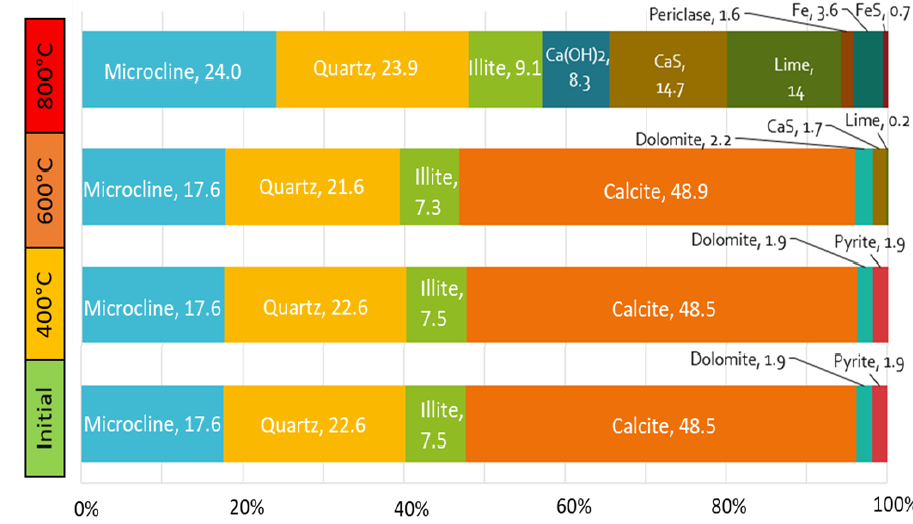
Figure 4. ( A ) Sample Ch-46t XRD patterns before the experiment and after heating at temperatures of 400 °C, 600 °C, and 800 °C. ( B ) Evolution of mineral composition during the experiment.